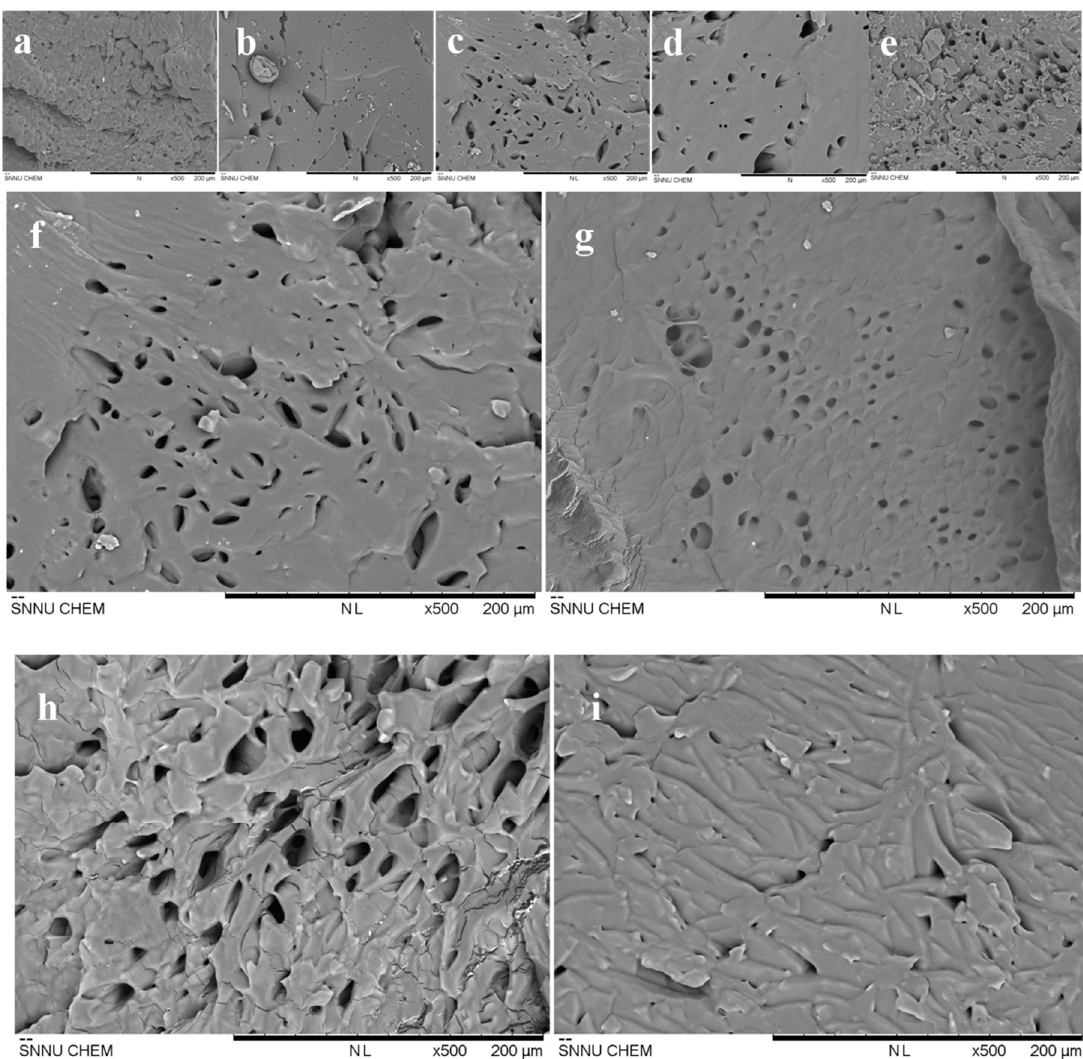
Figure 5. Morphology of freeze-dried gels at pH = 7, 25 ◦ C ( a ) gel4, ( b ) gel3, ( c ) gel2, ( d ) gel5, and ( e ) gel1. Morphology of freeze-dried gel2 ( f ) at pH = 7, 25 ◦ C, ( g ) pH = 7, 40 ◦ C, ( h ) pH = 5, 25 ◦ C, and ( i ) pH = 9, 25 ◦ C.